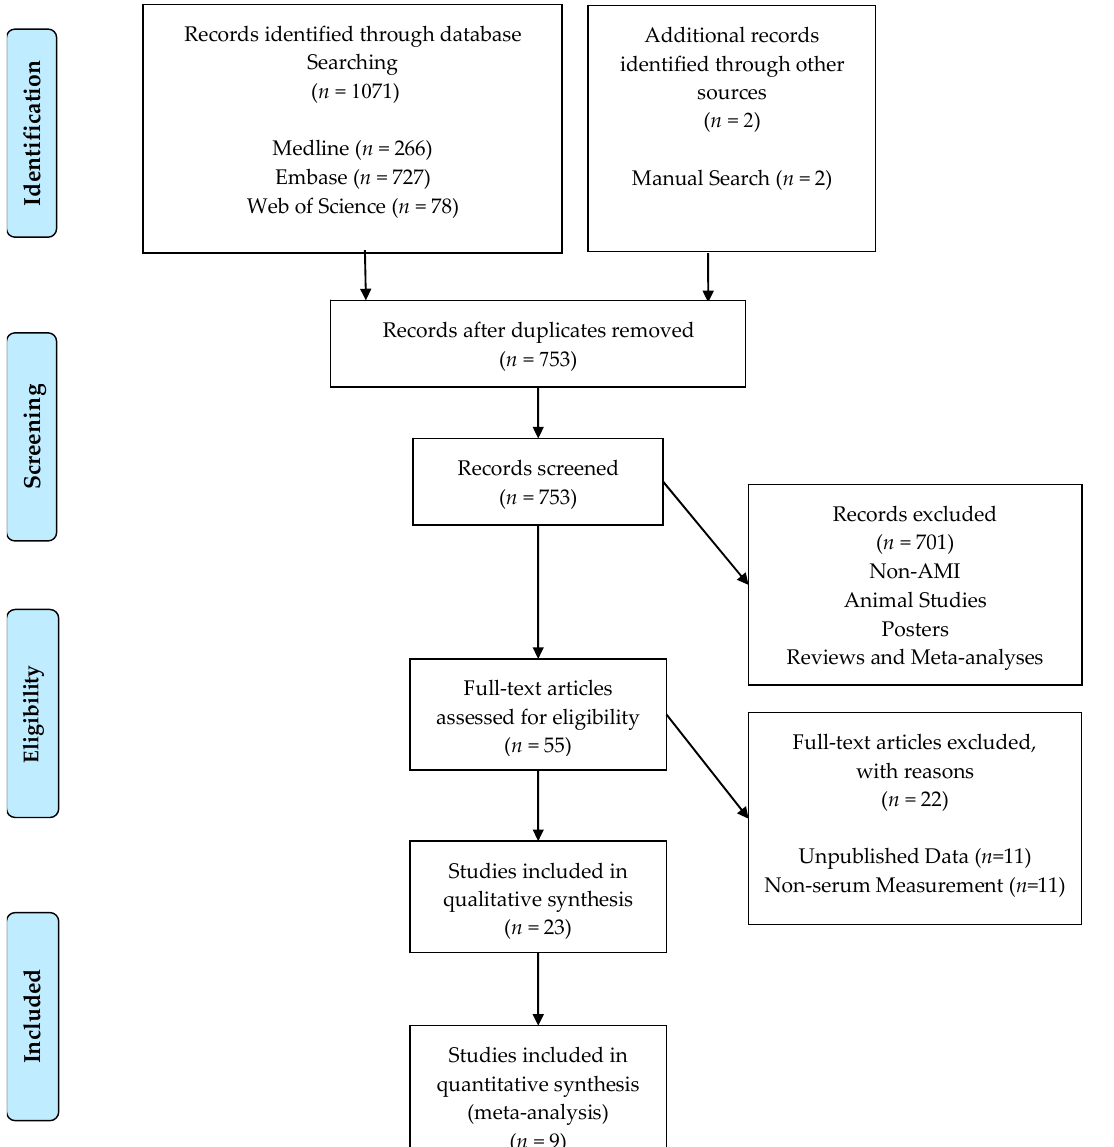
Figure 1. PRISMA flow chart of the study selection.